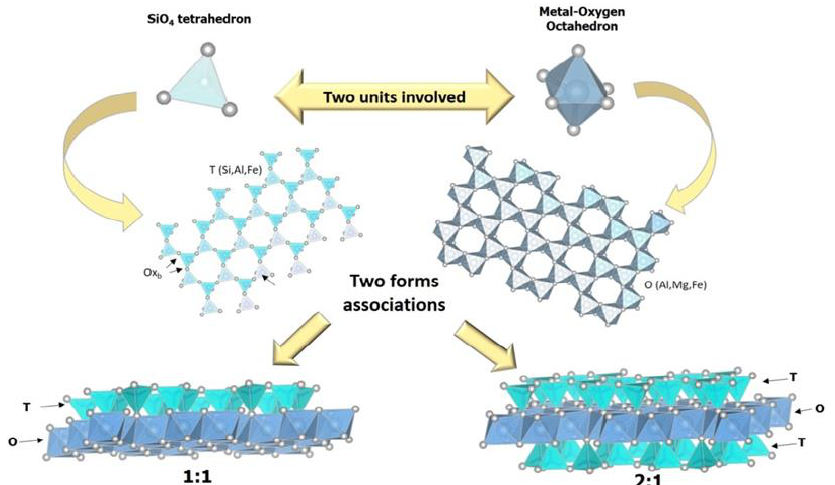
Figure 1. Representation of tetrahedral and octahedral sheets and 1:1 (TO) and 2:1 (TOT) arrange- ments in the structure of clay minerals. ments in the structure of clay